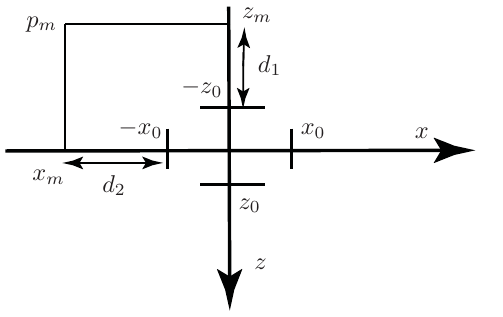
Figure 2: Determining d 1 and d 2 from the haptic position.